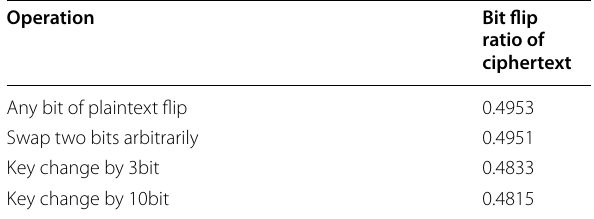
Table 3 Sensitivity analysis of ZPKG